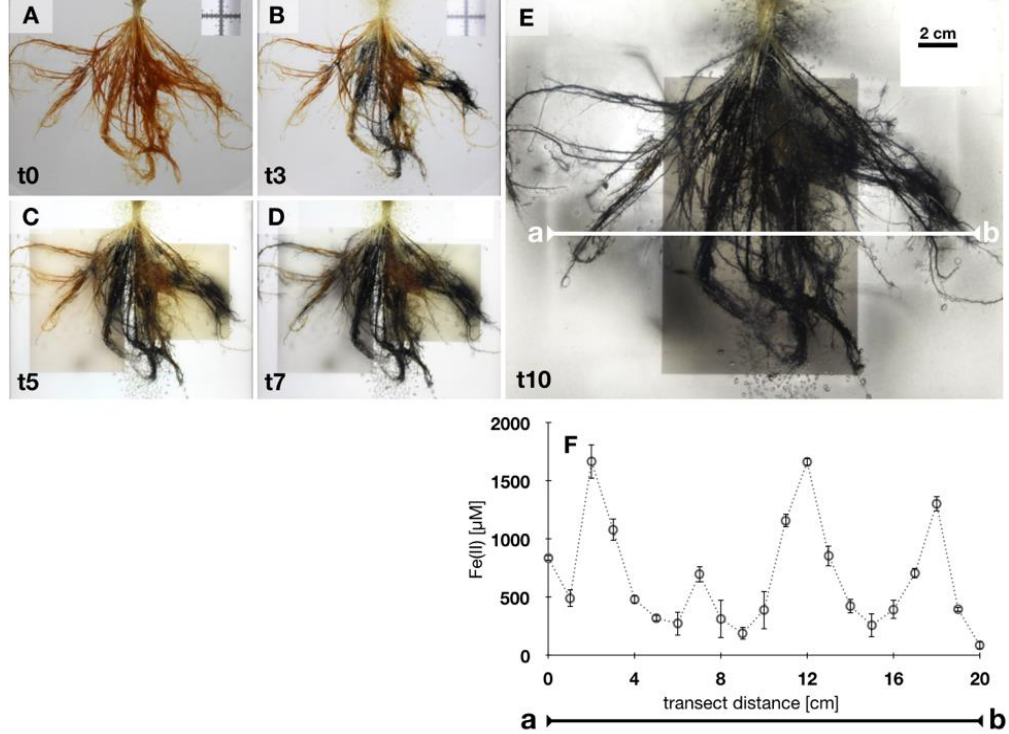
Figure 6. Microbial Fe(III) iron plaque reduction. ( A – E ): Roots covered with iron plaque minerals incubated in rhizotron with an Fe(III)-reducing enrichment culture. Iron plaque minerals change in color over time A, t0: day 0 – E,t10: day 10. ( F ): Voltammetric measurements along transect a-b in setup of Figure, after 10 days of incubation, detect Fe(II) remobilized from root iron plaque is closely associated with roots. Error bars represent standard deviation from triplicate voltammograms.